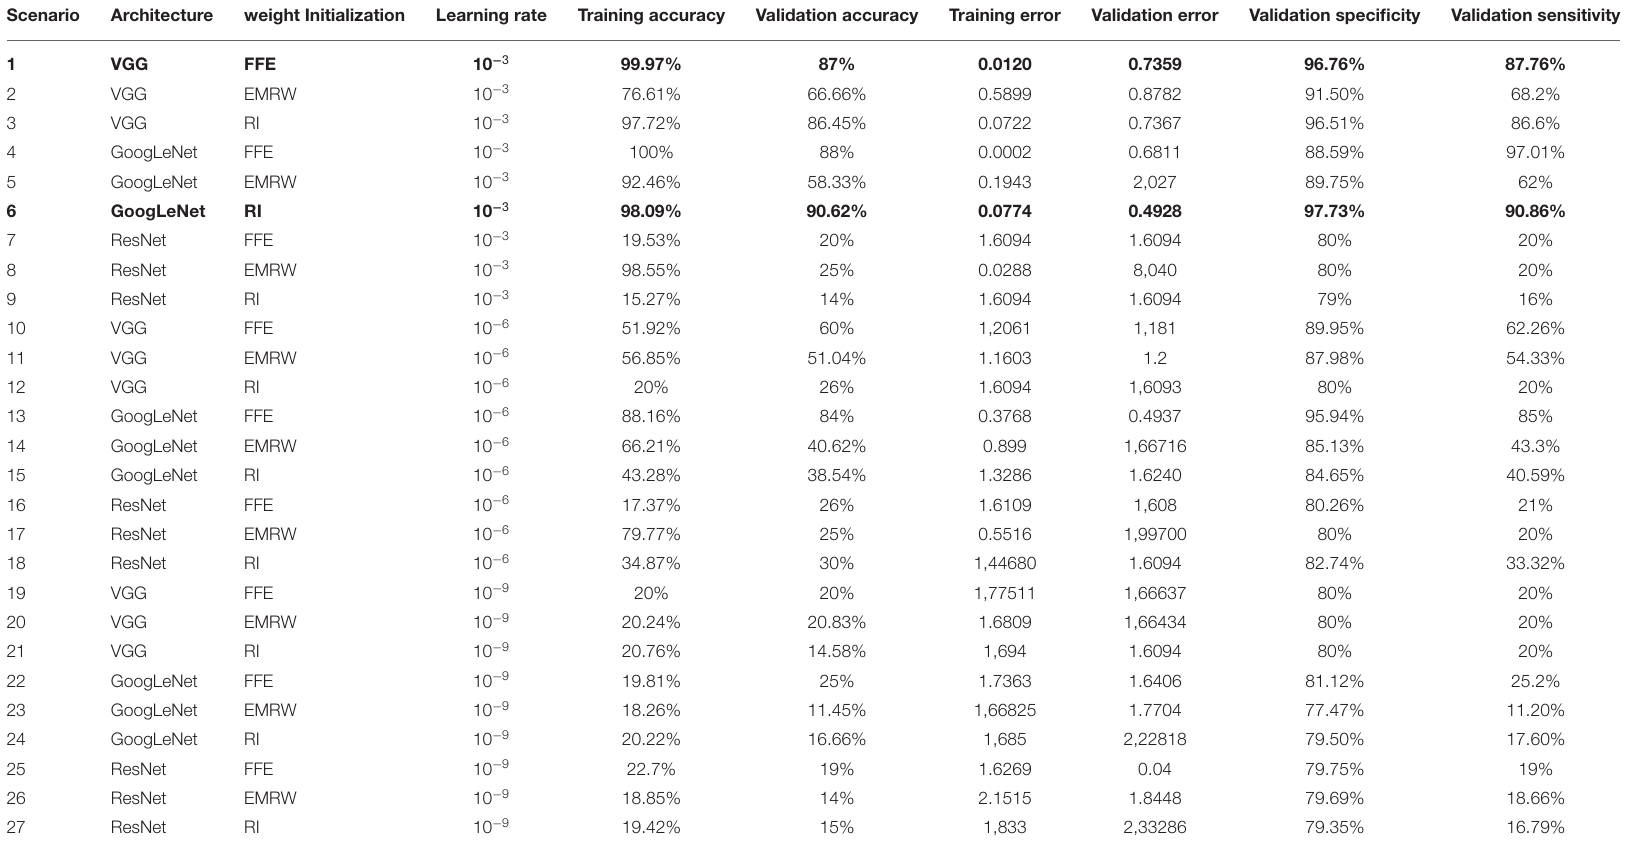
FFE, fixed feature extractors; EMRW, extension of the model and reinitialization of weights; RI, random initialization. The bold in lines for scenarios 1 and 6 of the this table, they were the best results obtained in the first